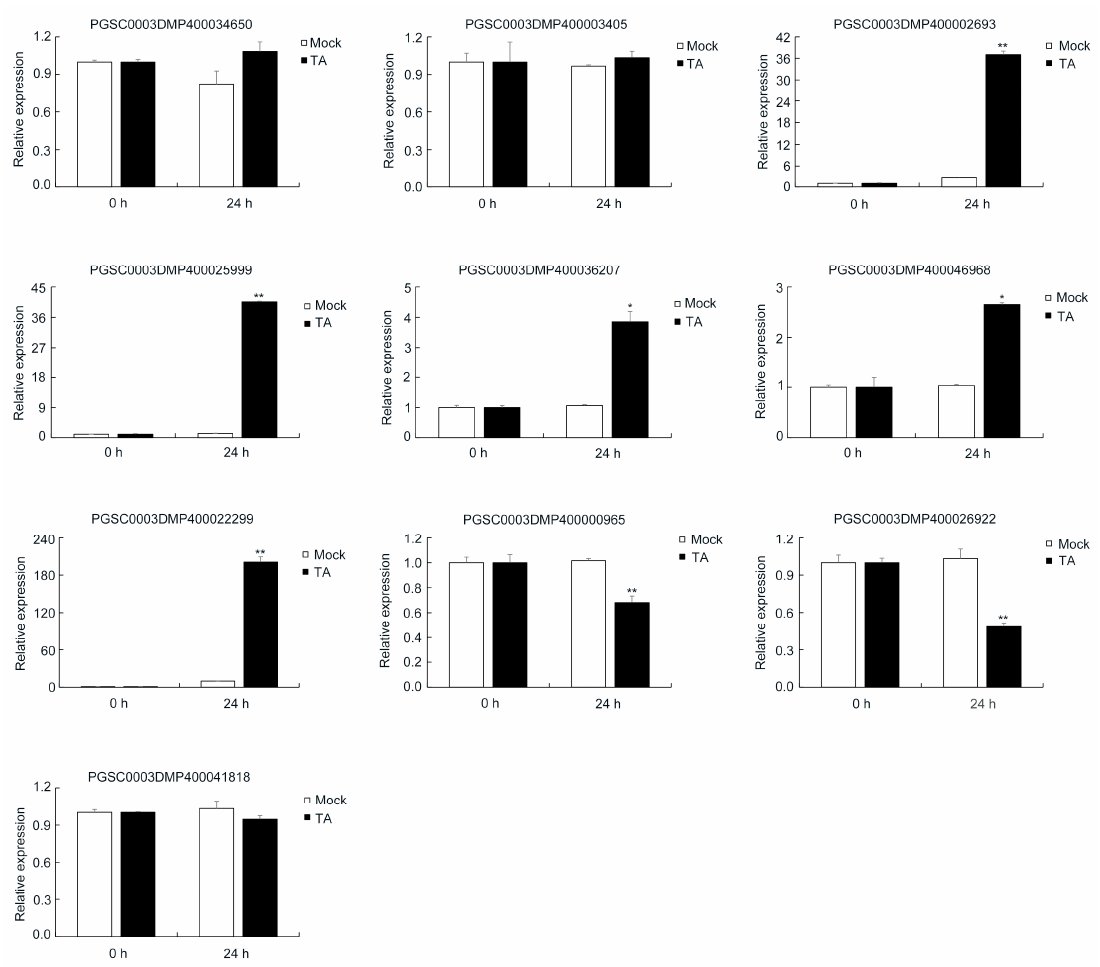
Figure 7. Quantitative reverse transcription-polymerase chain reaction (qRT-PCR) analysis of the expression change correlation between mRNA and DEPs. The asterisks denote statistically significant differences, as determined by a Student’s t -test, * p < 0.05, ** p < 0.01. Three biological repetitions were performed.